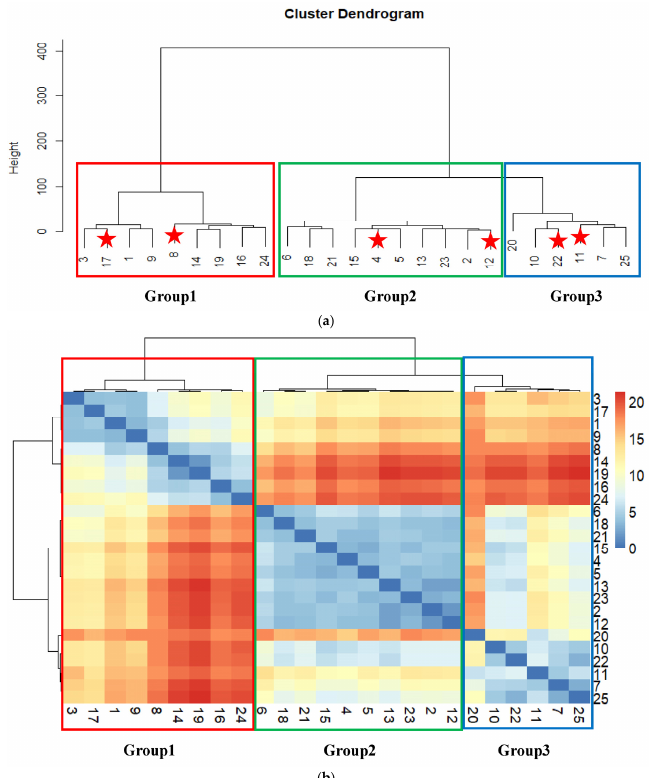
Figure 3. ( a ) Agglomerative cluster analysis of Ricinus communis based on 34 vegetative morpho- metric characters. Red asterisks show the six investigated samples using SEM. ( b ) Heatmap of Rici- nus communis based on 34 vegetative morphometric characters. The principal component analysis (PCA) performed for the twenty-five samples (Fig- ure 4), based on 27 quantitative characters, revealed that the first axis (Dimension 1)